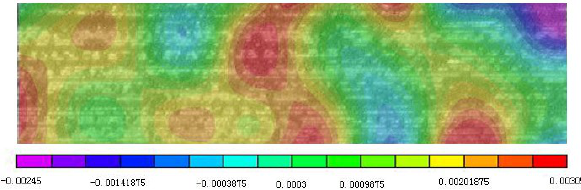
Figure 21: Strain distribution(Force=15N)